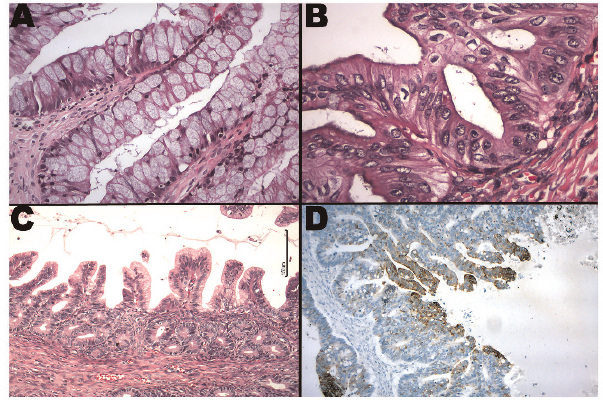
Figure 2 - Mucinous carcinomas with intestinal (A), Mullerian (B) and gastric (C) phenotypes. Focal cytokeratin 7 expression in a metastatic mucinous carcinoma is